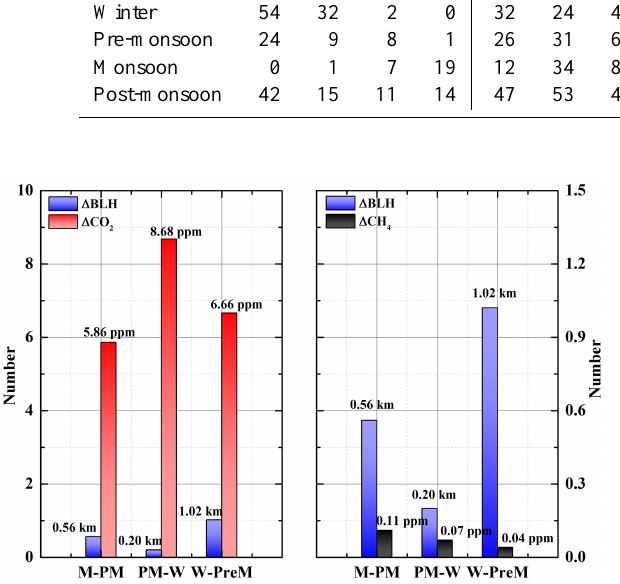
Figure 9. Seasonal differences in BLH against respective change in (a) CO 2 and (b) CH 4 .